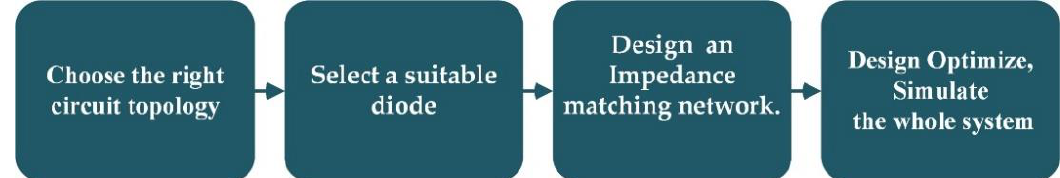
Figure 3. Block diagram of the design methodology in a rectenna system.